Question: In one sentence, what is this figure communicating?
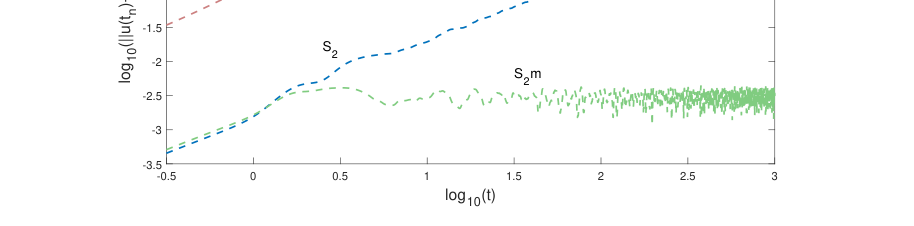
Answer: 6. Time-dependent Schr¨odinger equation with a double-well potential: relative error in the wave function as a function of 𝑡with ℎ= 1/20 for Strang (𝑆2), Lie-Trotter (LT) and scheme 𝑆2𝑚involving a double commutator and conjugate to a method of order 4.